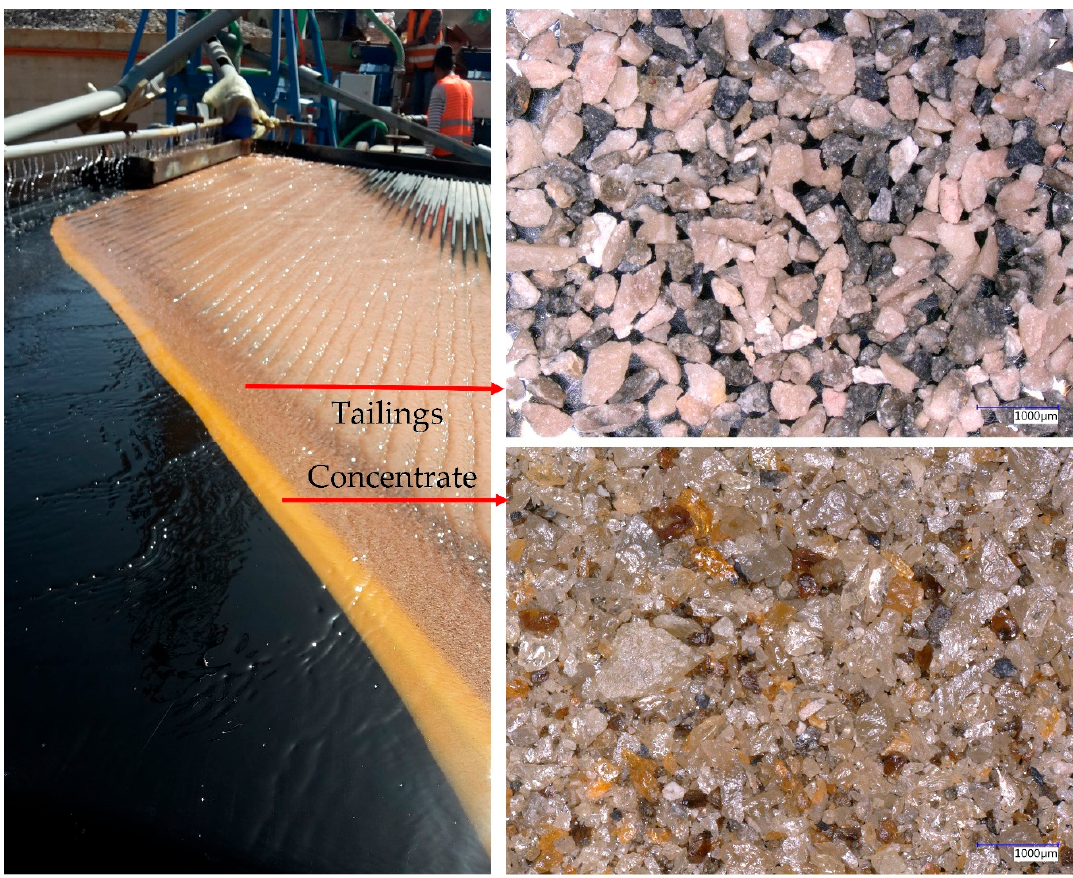
Figure 7. Split of yellow high-grade lead vanadate on the shaking table with microscope images of the concentrate and tailings